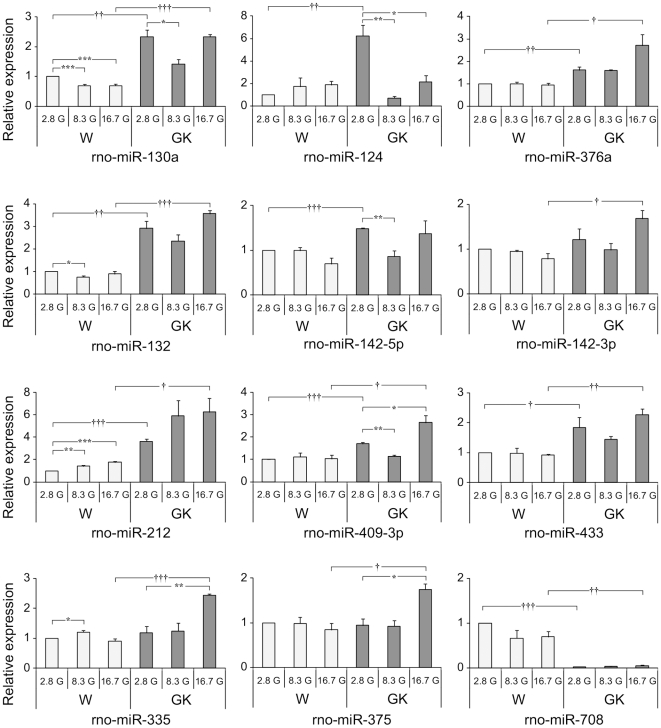
Glucose-dependence of miRNA expression after 1 h incubation at 2.8 mM, 8.3 mM and 16.7 mM glucose.More pronounced variation of miRNA expression trajectories (magnitude and direction of expression) were observed in the GK compared to Wistar islets across the different glucose concentrations. Each miRNA was normalized to the geometric mean of U6 snRNA and U87 rat. The 2-ΔΔCt method was used for relative quantification using Wistar expression level at 2.8G as calibrator. The presented data are the average of N = 3 biological replicates performed independently each in triplicate qPCR wells ± SEM. Intra-sample (within same animal group) significance denoted by (*) P<0.05, (**) P<0.01, (***) P<0.001 vs 2.8G of same animal group. Inter-sample (W vs GK) significance denoted by (†) P<0.05, (††) P<0.01, (†††) P<0.001, compares expression levels from different animal groups of the same incubating glucose concentration. Different y-axis scaling was used for each miRNA to allow easy comparison of expression levels across different conditions.